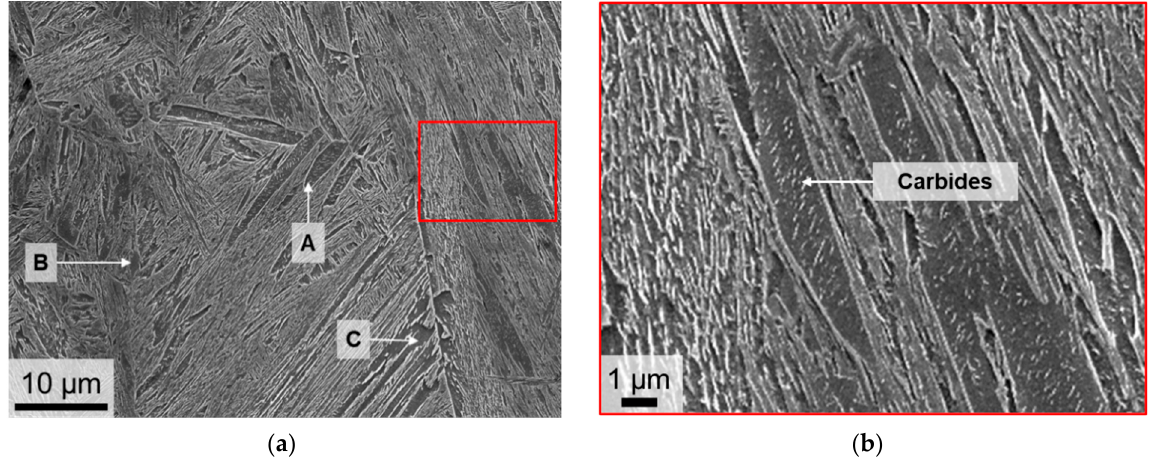
Figure 6. SEM micrograph of the as-received microstructure of the present steel. ( a ) General view, ( b ) magnification of red area in ( a ).